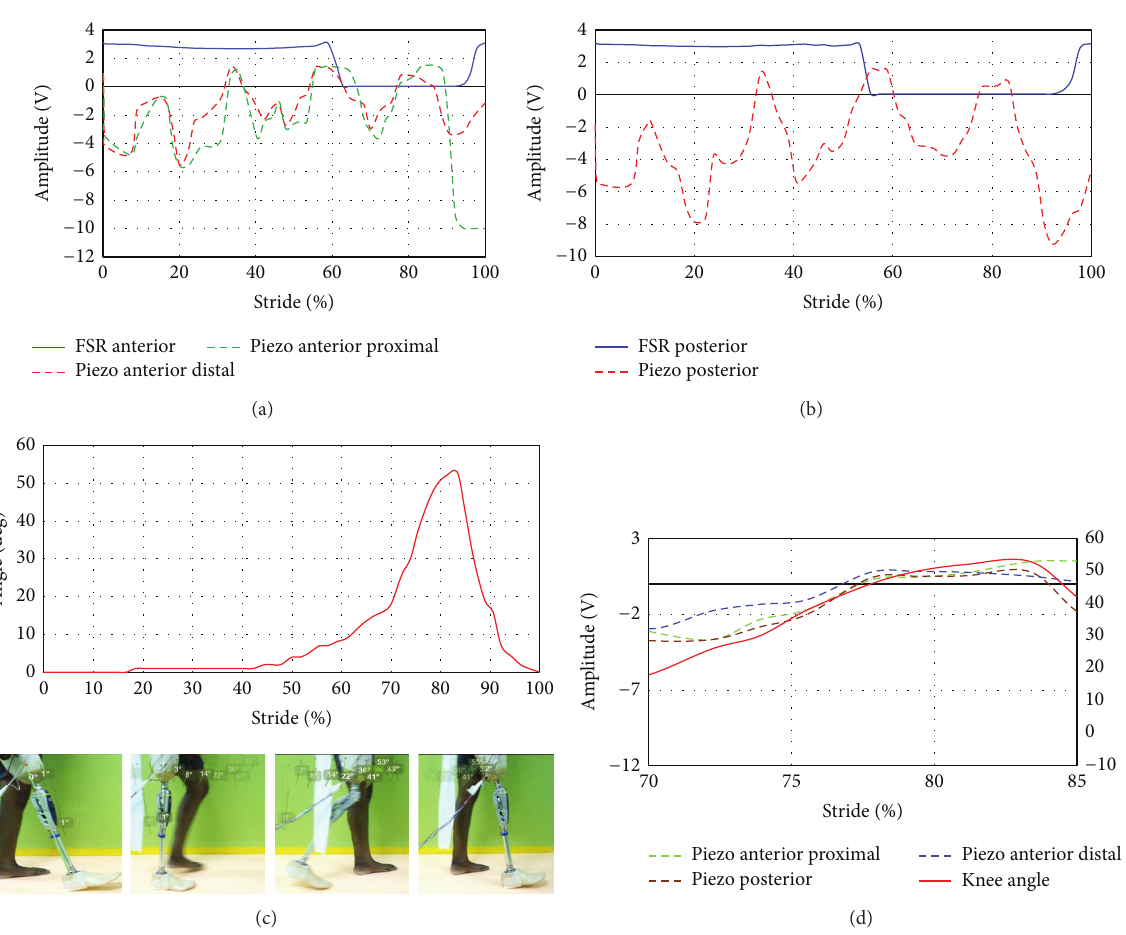
Figure 7: FSR and piezoelectric sensors output during gait cycle: (a) FSR anterior, piezo anterior distal, and piezo anterior proximal sites, (b) FSR and piezoelectric sensors at posterior sites, (c) knee angle during stride, and (d) piezoelectric sensors with the knee angle at a region from 70% to